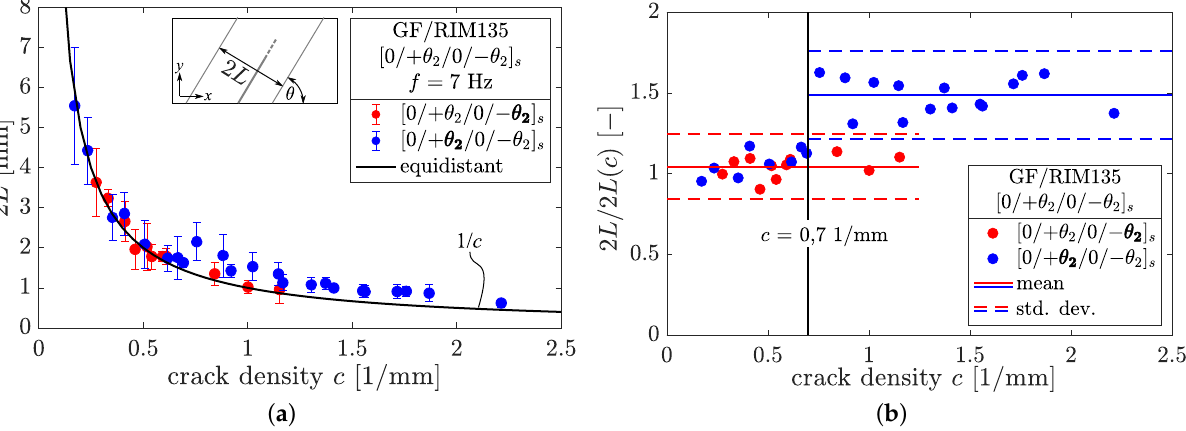
Figure 14. ( a ) Measured crack spacings of individual cracks compared to equidistant crack spac- ing as determined by the detection algorithm; ( b ) the ratio of real and equidistant crack spacing for several crack densities. Data were gathered from [ 0/ + 75 2 /0/ − 75 2 ] s , [ 0/ + 65 2 /0/ − 65 2 ] s , and [ 0/ + 55 − 55 ] s 2 /0/ 2